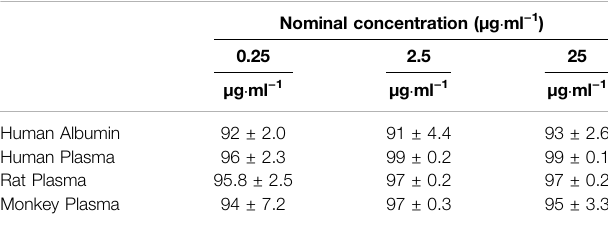
TABLE 4 | Observed and simulated pharmacokinetic parameters of MK-ASODN nanoliposomes after intravenous administration to monkeys and